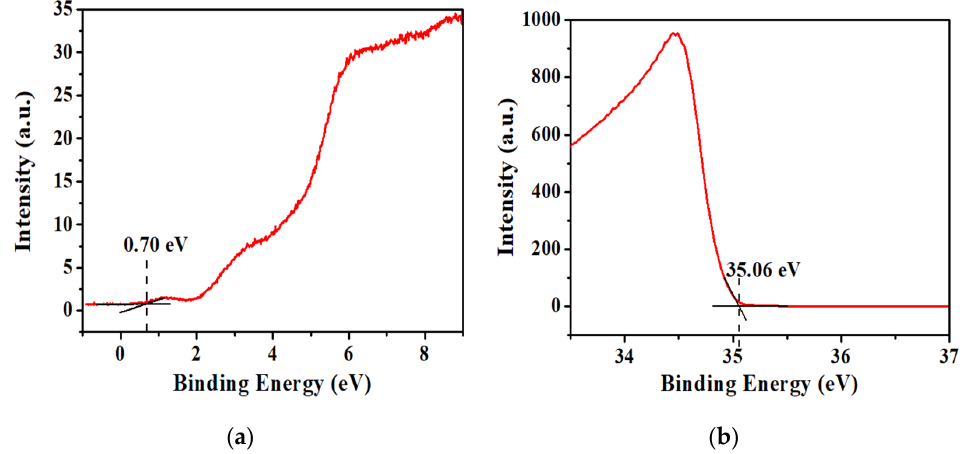
Figure 4. The measured ultra-violet photoelectron spectroscopy (UPS) spectra showing ( a ) highest occupied molecular orbital (HOMO) onset and ( b ) cut-off energy for the determination of VTTBNc’s HOMO level.